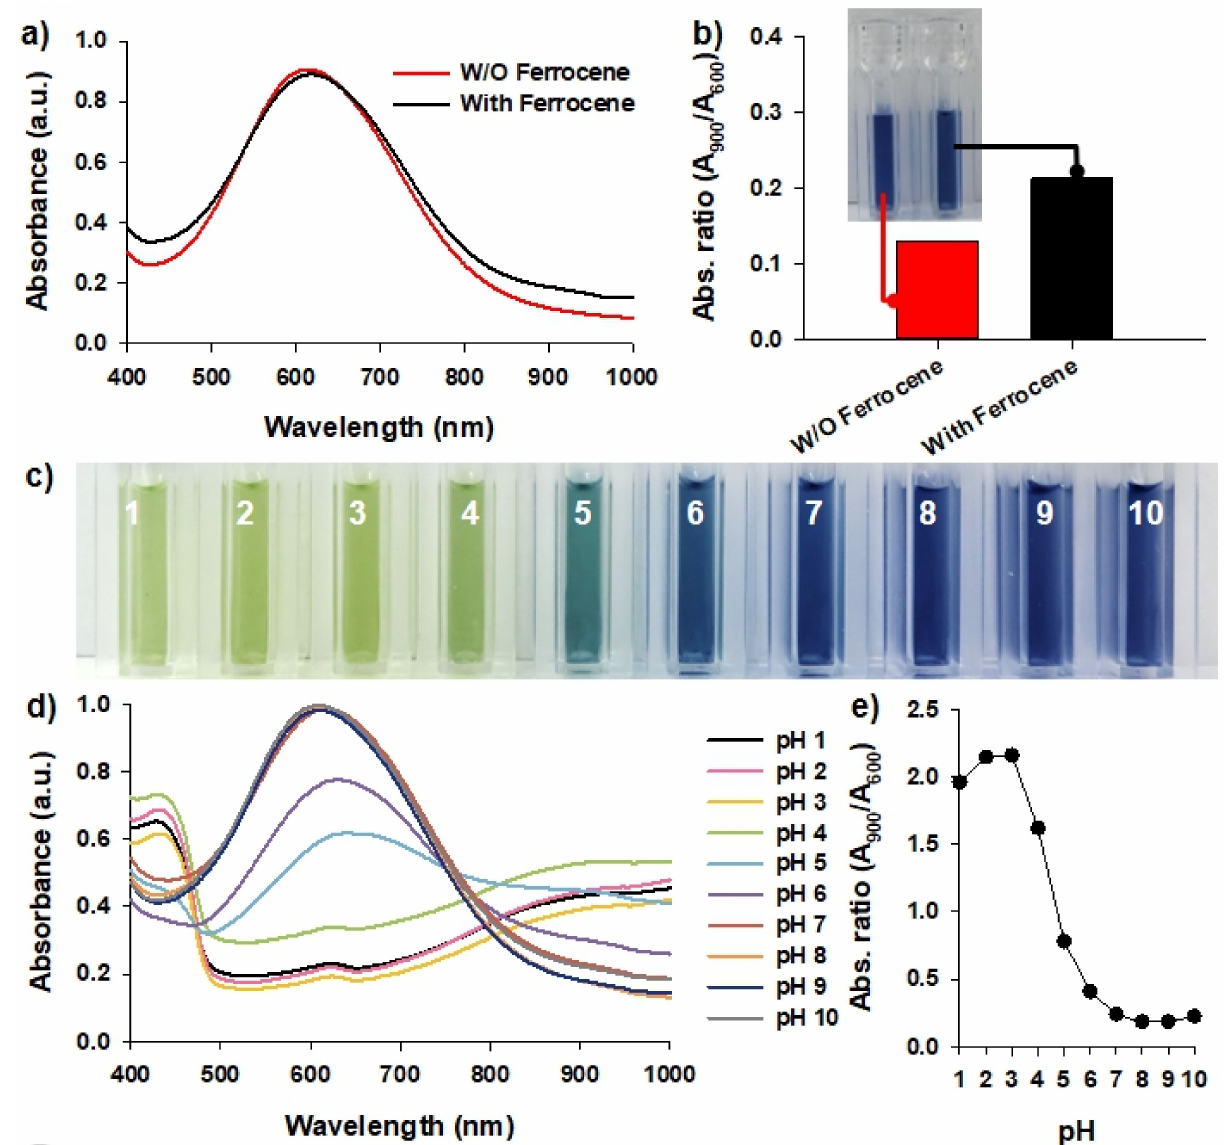
Figure 3. ( a ) Absorbance spectra, ( b ) absorbance ratios (A 900 /A 600 ) about TPAni nanoparticles with or without ferrocene (Inset: photograph of TPAni solutions), ( c ) photograph, ( d ) absorbance spectra, and ( e ) absorbance ratios (A 900 /A 600 ) of TPAni nanoparticles with ferrocene in pH solutions (from pH 1 to